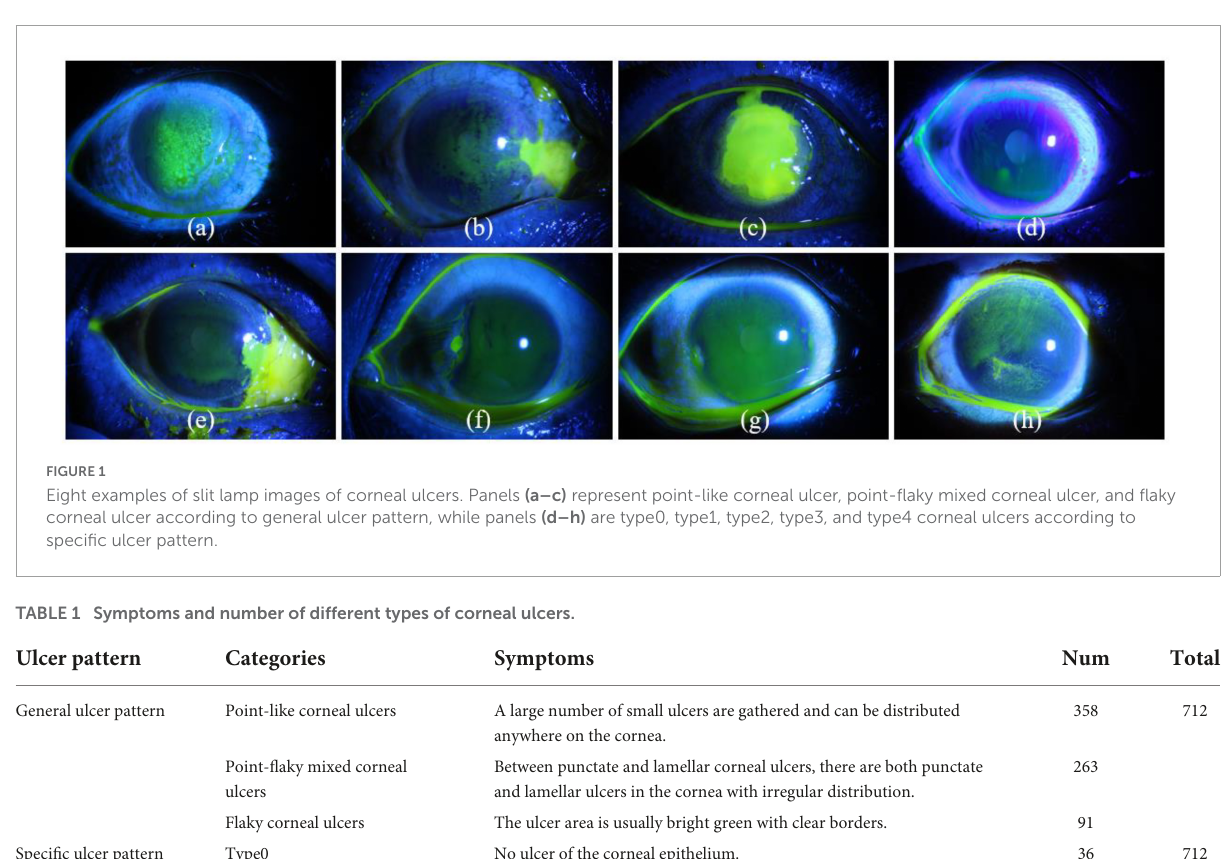
Point-flaky mixed corneal ulcers